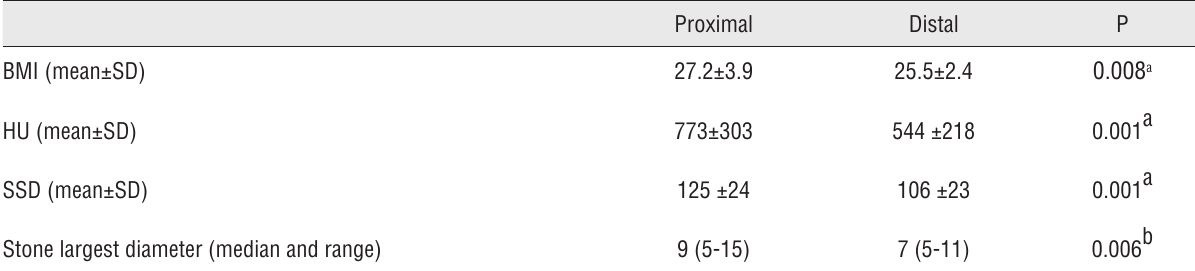
Table 1 - Proximal and distal ureteral stones’